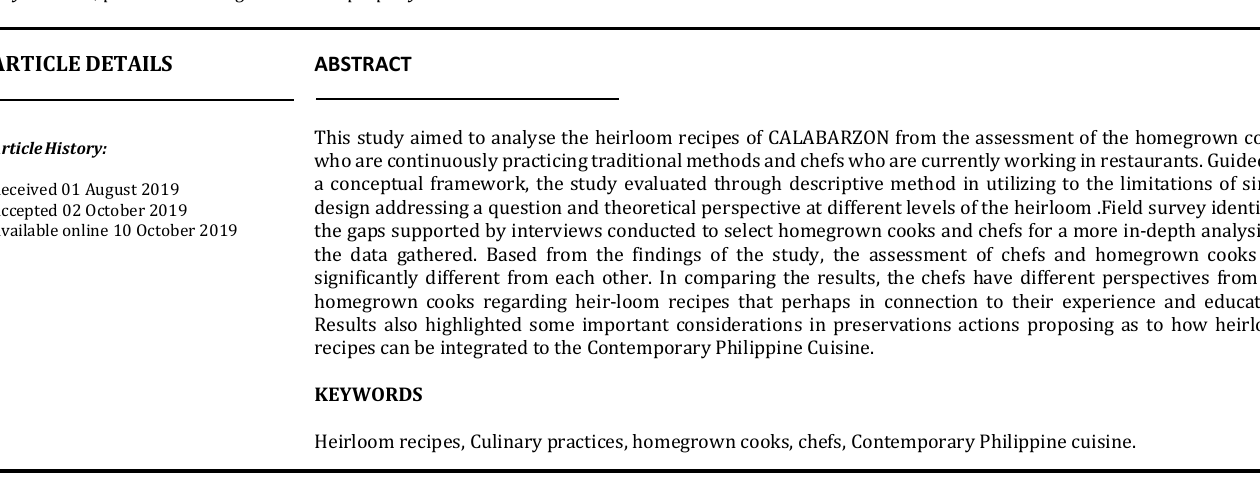
Research Paradigm 4. STATEMENT OF THE